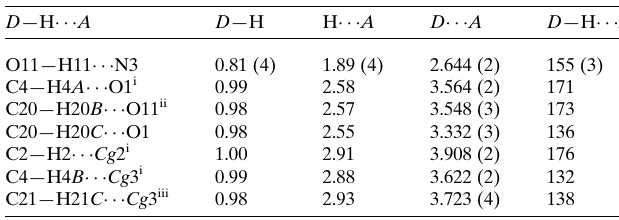
Table 1 Hydrogen-bond geometry (A˚ , (cid:2) ).